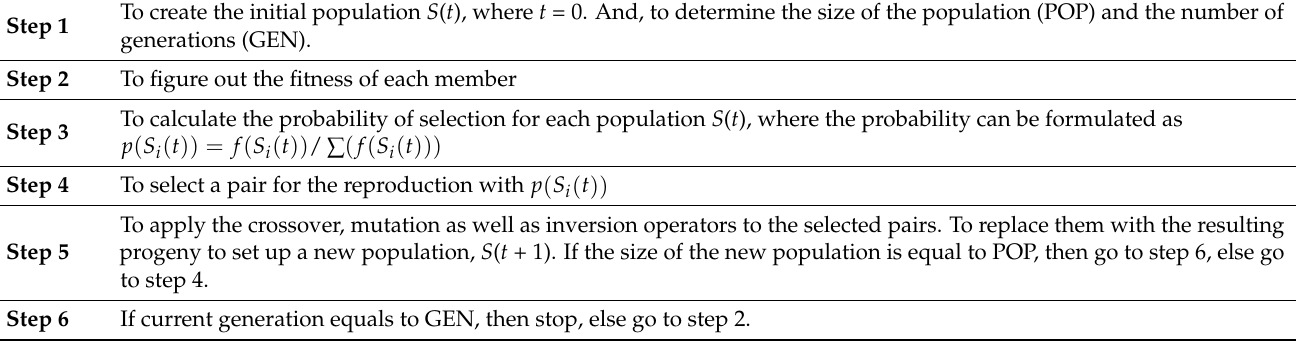
Table 8. Genetic